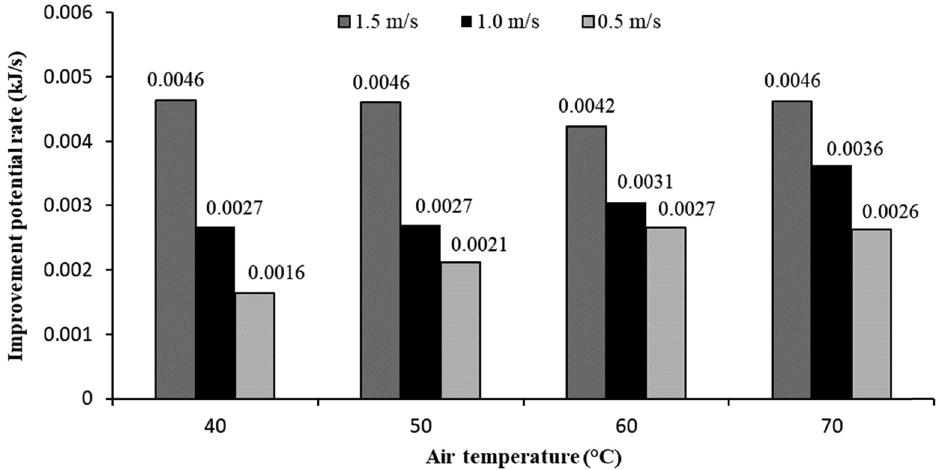
Figure 6: In fl uence of air temperature and velocity on the exergy IP rate for the drying of potato slices.